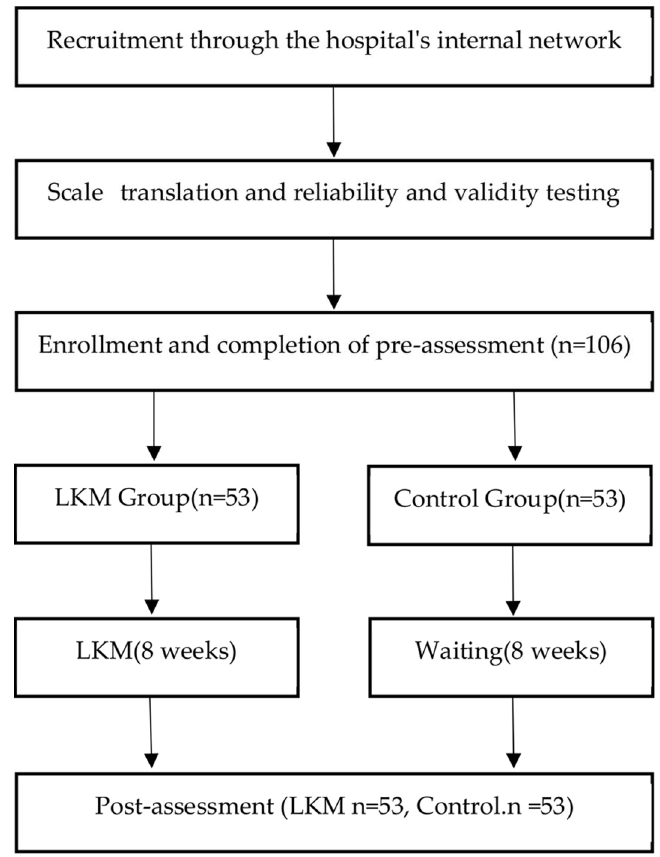
Figure 1. Procedure flow chart.